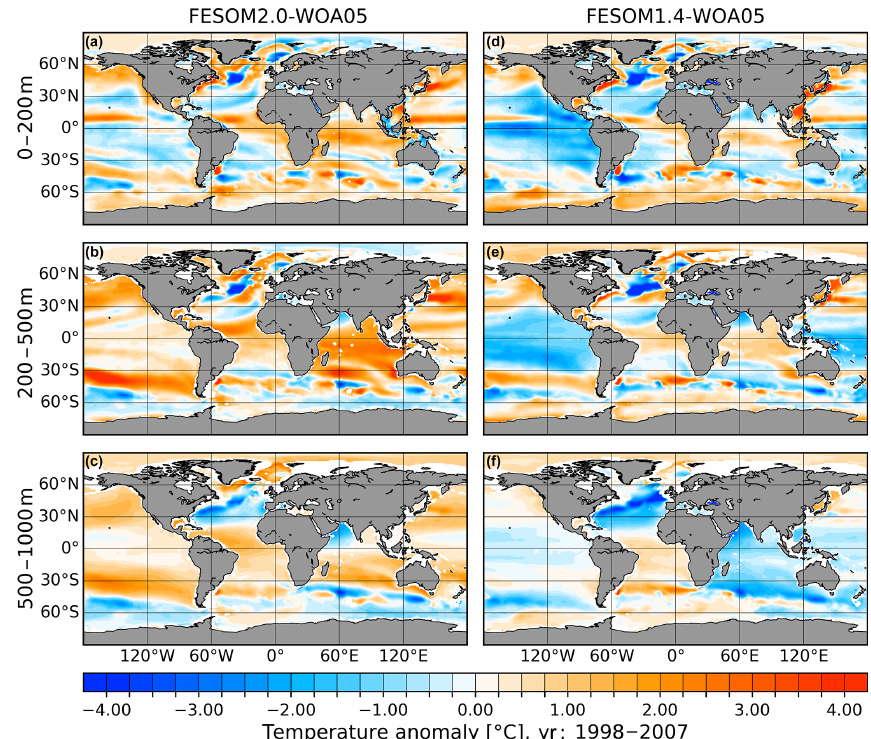
Figure 14. Temperature biases referenced to WOA05 (Locarnini et al., 2006; Antonov et al., 2006) climatology for FESOM2.0 (a–c) and FESOM1.4 (d–f) . Model results are averaged over the period of 1998–2007. From top to bottom, averages over three depth ranges are shown: 0–200m (a, d) , 200–500m (b, e) and 500–1000m (c, f)